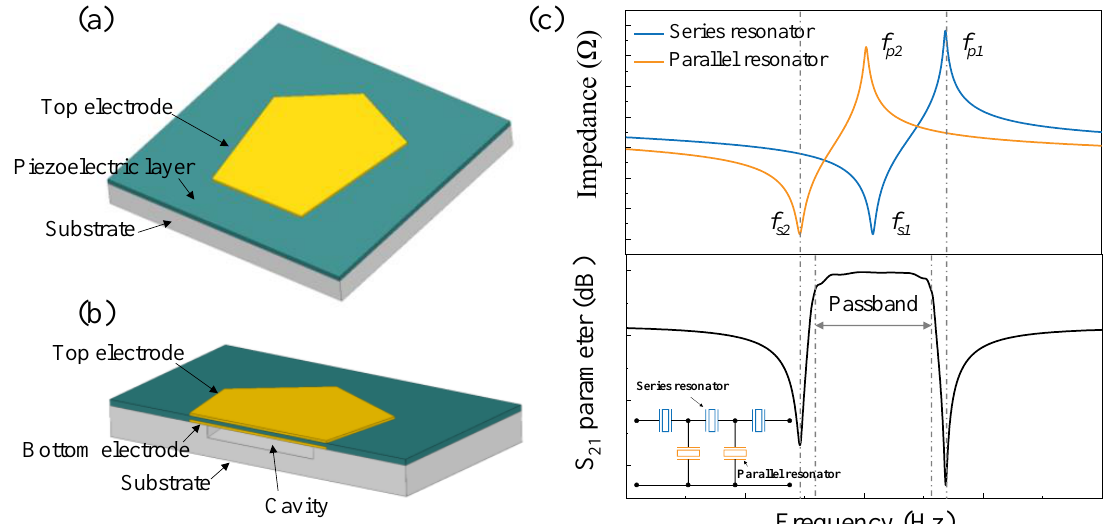
Figure 2. Structures of FBAR and characteristics of filters. ( a ) Schematic drawing of a typical FBAR. ( b ) The cross-sectional view of FBAR. ( c ) Working principle of filter based on FBARs. Inset shows the ladder circuit topology of filters.